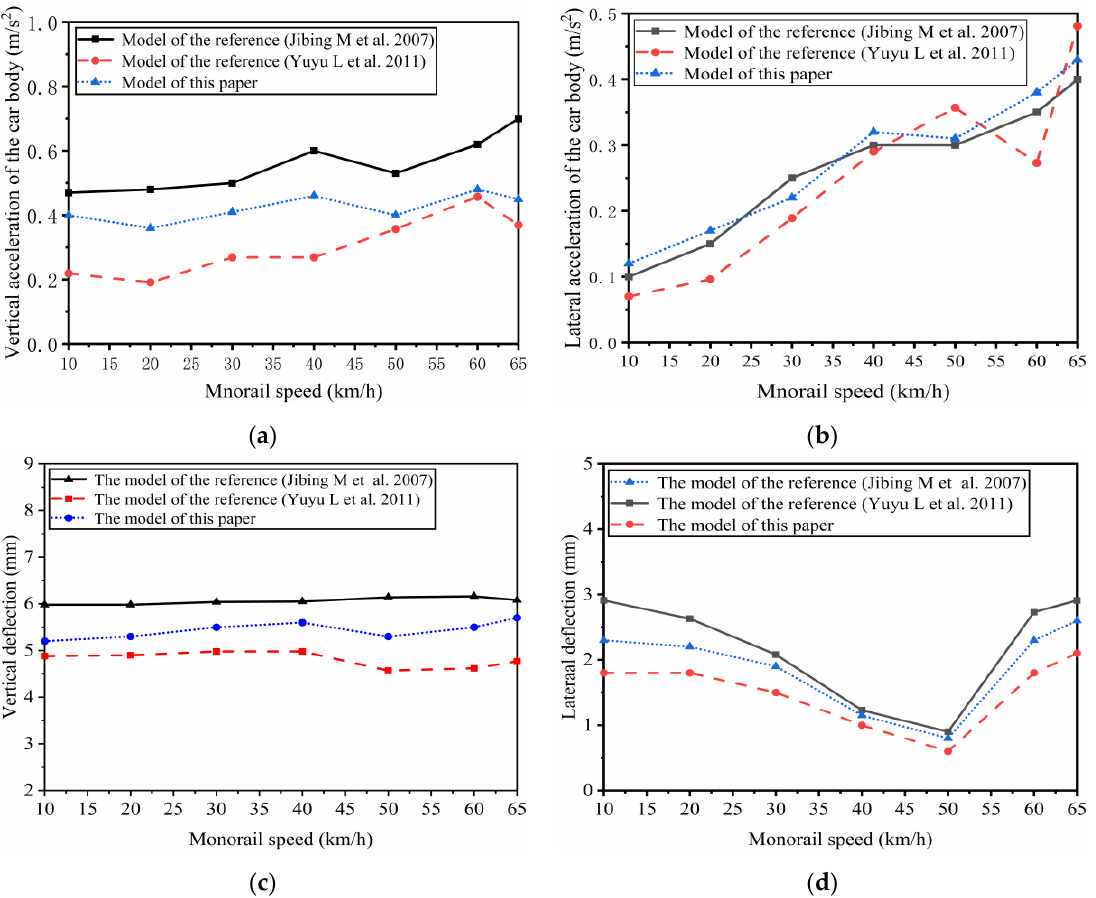
Figure 8. The validation of the dynamic model with Yuyu L et al. 2011 and Jibing M. 2007 [16,17] : ( a ) The vertical acceleration of the vehicle body; ( b ) The lateral acceleration of the vehicle body; ( c ) The vertical deflection at the middle span; ( d ) The lateral deflection at middle span